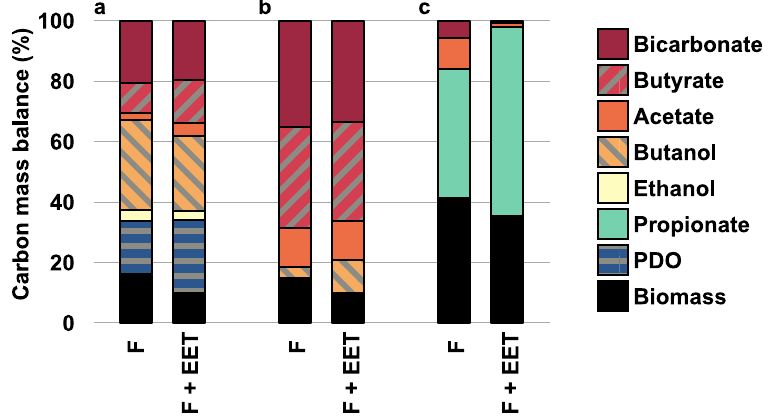
Figure 2. Carbon mass balances for: ( a ) Glycerol fermentation by C. pasteurianum in pure culture (F) and in co-culture with G. sulfurreducens (F + EET) 18 ; ( b ) Glucose fermentation (F) and electro-fermentation (F + EET) by C. pasteurianum 13 ; ( c ) Glucose fermentation (F) and electro-fermentation (F + EET) by P. freudenreichii 8 . Values are normalized on initial glycerol or glucose carbon content, and bicarbonate is used as adjustment variable to close the balance. The abbreviation "PDO" stands for 1,3-propanediol. The particularly high biomass yield displayed in ( c ) is likely related to the presence of yeast extract in the fermentation